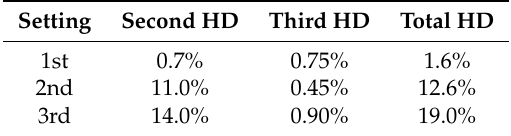
Table 4. Second, third, and total harmonic distortion (HD) at the different settings. Setting